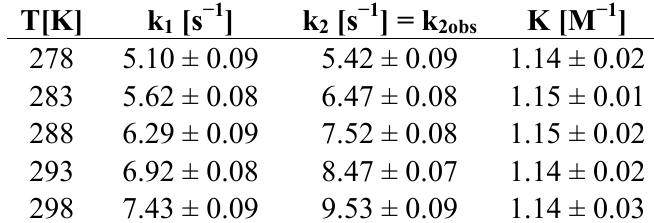
, k ) and protonation constant (K) of 1 2